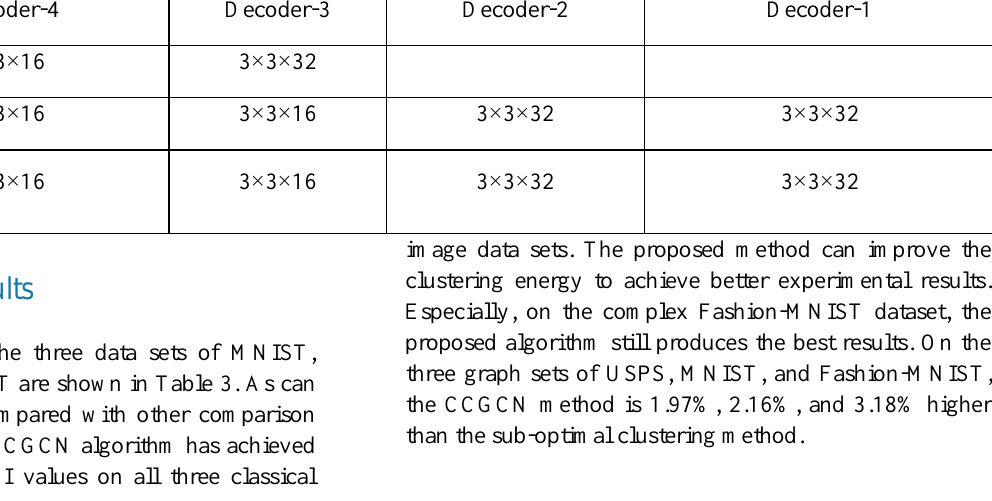
Table 3. Clustering results of different clustering algorithms on three